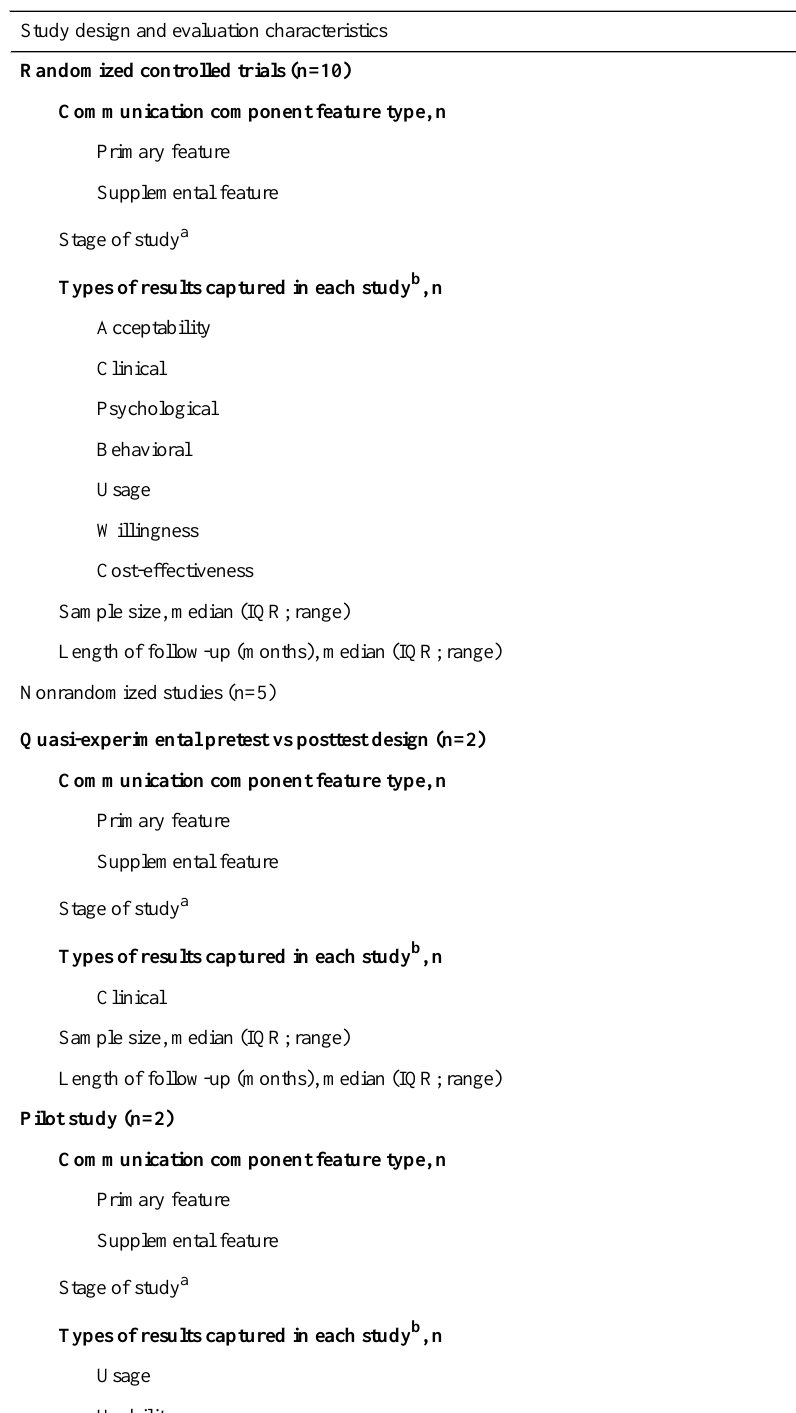
Table 4. Assessment of the characteristics of unique studies (n=15). Unique studies were defined as the studies that led to several publications. These did not include editorials, protocols, or